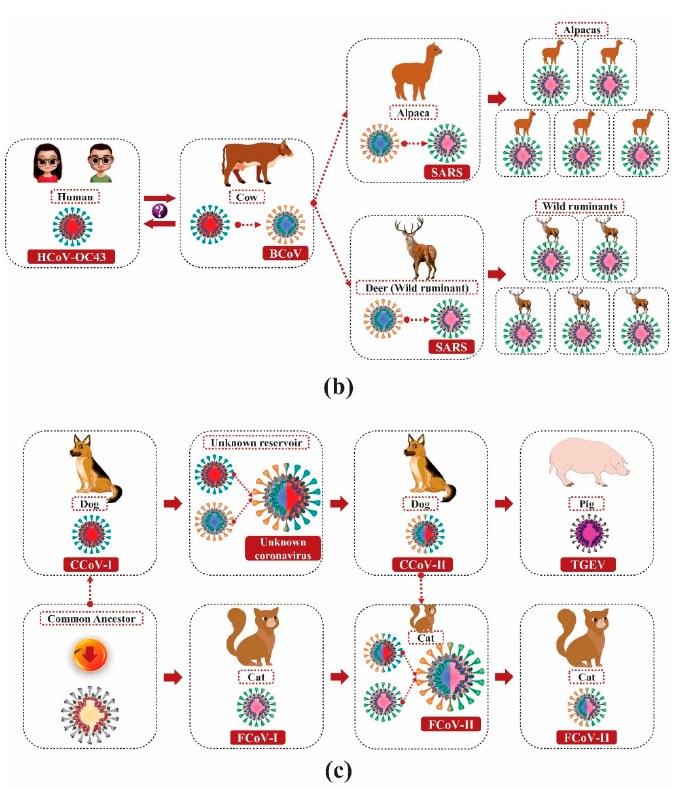
Figure 2. Transmission of coronavirus between different species: ( a ) Coronavirus whose natural reservoir are bats (BtCoV) is like coronavirus of the Severe Acute Respiratory Syndrome (SARS). This virus has spread and adapted to wild animals, for example, masked palm civet, which is marketed for human consumption in wholesale seafood markets in China. The employees of these markets that manipulate these wild animals have been infected; however, they did not present important clinical signs, and symptoms were minimal. The process of adapting the virus to new hosts resulted in strains with efficient replication capacity in human hosts, which cause diseases with clinical conditions ranging from mild to severe and with great ability to spread from person to person; ( b ) OC43 coronavirus, whose natural reservoir are humans (HCoV-OC43) and bovine coronavirus (BCoV) are closely related. It is postulated that these coronaviruses originated in another animal species and subsequently have crossed their species. BCoV has e ff ectively spread among other animal species, for example, alpaca (South American mammal of the camelid family) and wild ruminants (such as deer); ( c ) Currently, some canine viruses are believed to have common ancestors with feline species. This occurs with coronaviruses that infect these species. Currently, feline coronavirus I (FCoV-I) and canine coronavirus I (CCoV-I) are believed to share a common ancestor. A recombination process (random exchange of genetic material) of CCoV-I with an unknown coronavirus gave rise to a second type of canine coronavirus (CCoV-II). The recombination of CCoV-II with FCoV-I in an unknown host gave rise to a second type of feline coronavirus (FCoV-II). There is evidence that CCoV-II was transmitted to pigs, originating the transmissible gastroenteritis virus (TGEV) [36]. Note: This image was developed using the CorelDraw software (2017 Corel Corporation ID